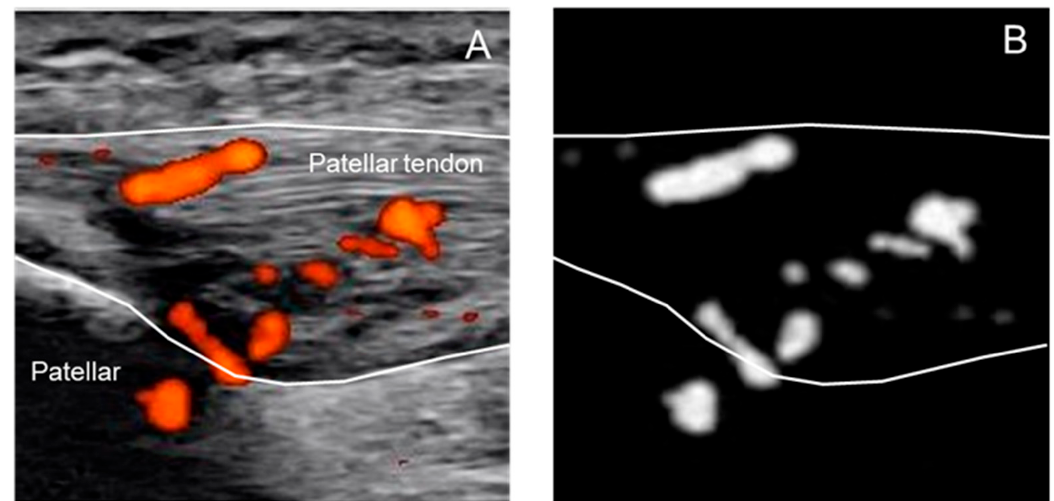
Figure 2. Measurement for blood flow area, ( A ) ultrasound Image, ( B ) analysis image using image J.